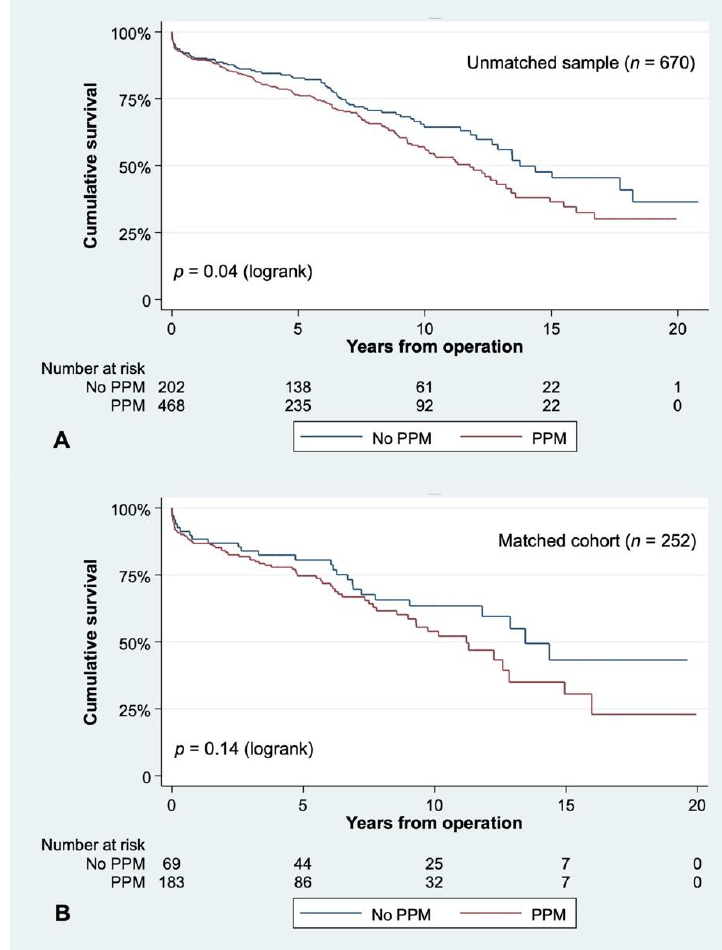
Figure 3. Long-term survival according to the presence of PPM (EOAi ≤ 0.85 cm 2 /m 2 ) in the unmatched ( A ) or matched ( B ) sample. When matching for risk factors, there was no difference in survival. Table 4. Cox proportional hazard regression of the all-cause mortality in the unmatched population ( n = 670) and in the matched population, with valve size or PPM as risk factors in the propensity- matched cohort ( n =